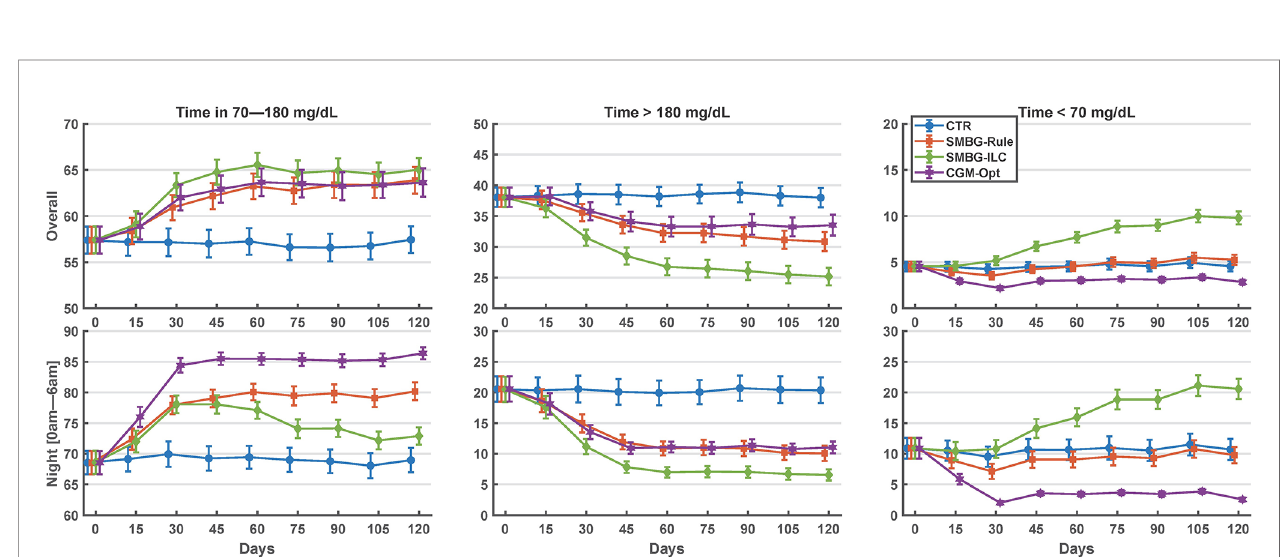
FIGURE 1 | Summary of glycemic outcomes in every 15 days period for the nominal scenario of the in-silico experiment. Values are shown as mean and standard deviation.